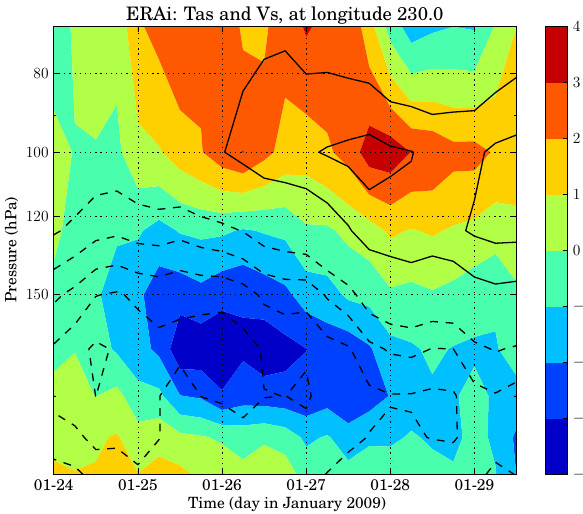
Figure 6. Hovmöller diagram of symmetric meridional wind (con- tours, dashed for negative values) and antisymmetric temperature anomalies (colour, K) in the ERA-Interim reanalysis, before and during the period of the simulation, at longitude 130 ◦ W. The aver- ages are computed between 15 ◦ N/S and the antisymmetric stands for antisymmetric relative to the